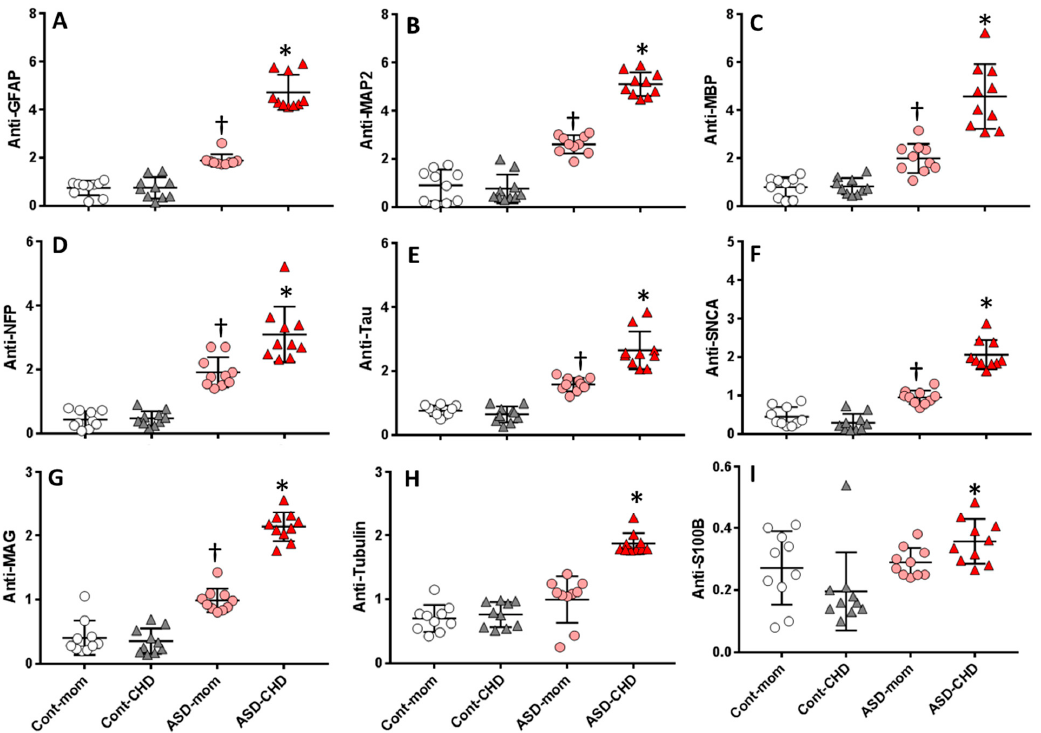
Figure 5. Scatter Plot showing the distribution of neural autoantibodies in Control Children’s mothers (Cont-M), Control children (Cont-C), ASD children’s mothers (ASD-M), ASD children (ASD-C) relative to the total IgG levels. Autoantibodies against ( A ) GFAP. ( B ) MAP2, ( C ) MBP, ( D ) NFP, ( E ) Tau, ( F ) SNCA, ( G ) MAG, ( H ) Tubulinand, ( I ) S100B. The cross line on the dot plot represents the mean values for each protein. The vertical line represents SEM. † P > 0.05 or * P < 0.01 is considered significant.